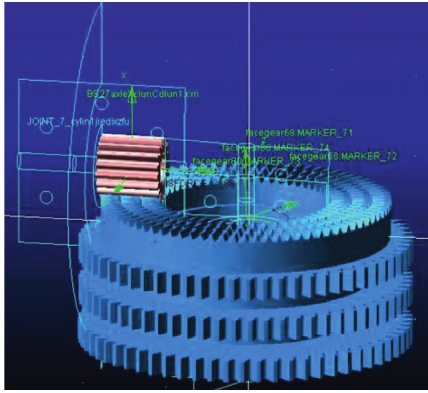
Figure 16: Dynamic model analysis of multistage face gear in ADAMS.